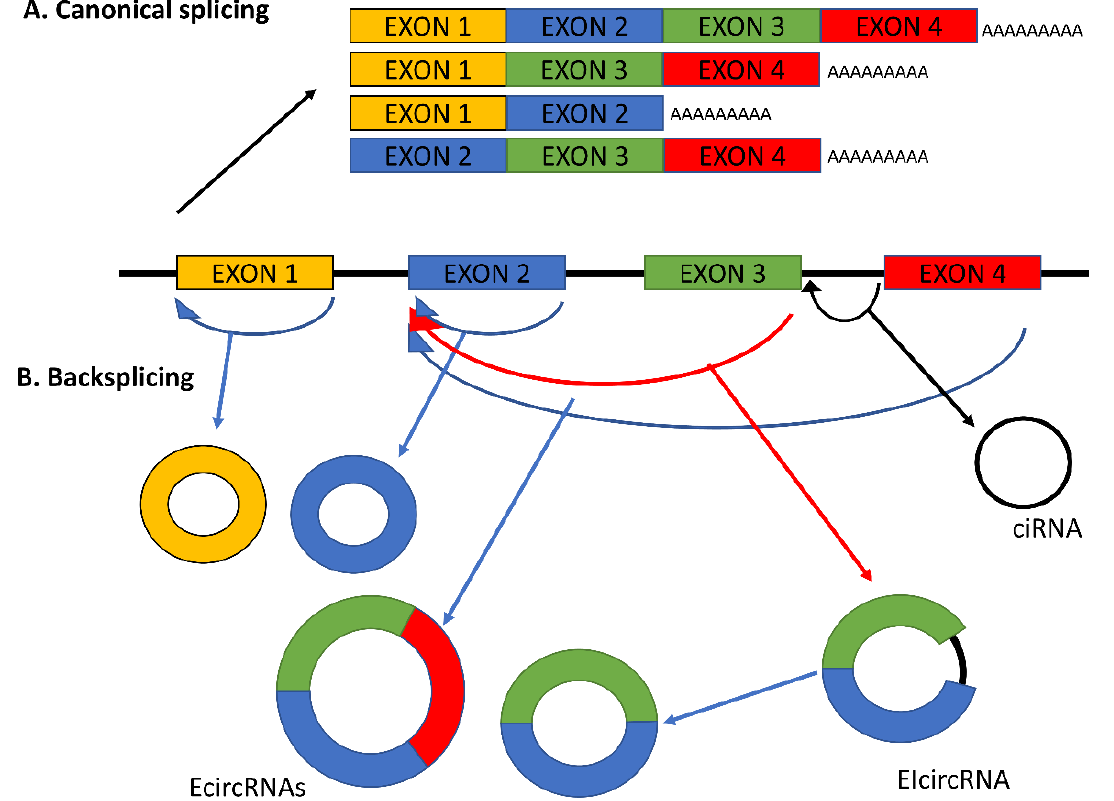
Figure 1. Schema of pre-mRNA splicing. ( A ) Canonical splicing with alternative splice products. ( B ) Backsplicing with the major types of circular RNAs (circRNAs) generated by the junctions of exons, introns, or both. (1) Exonic circRNAs (EcircRNAs). (2) Exon-intron circRNAs (EIcircRNAs) that are circularized with introns retained between exons. (3) Circularized intron RNAs (ciRNAs). Several circRNA isoforms can be produced from a single gene locus.